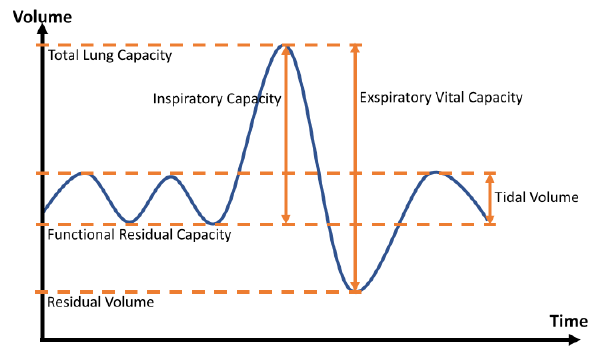
Figure 1. Schematic representation of the change in volumes over time.